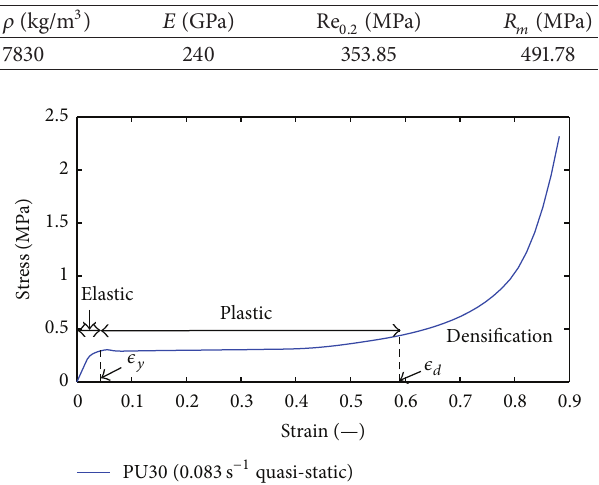
Table 1: Mechanical properties of S355JR steel.